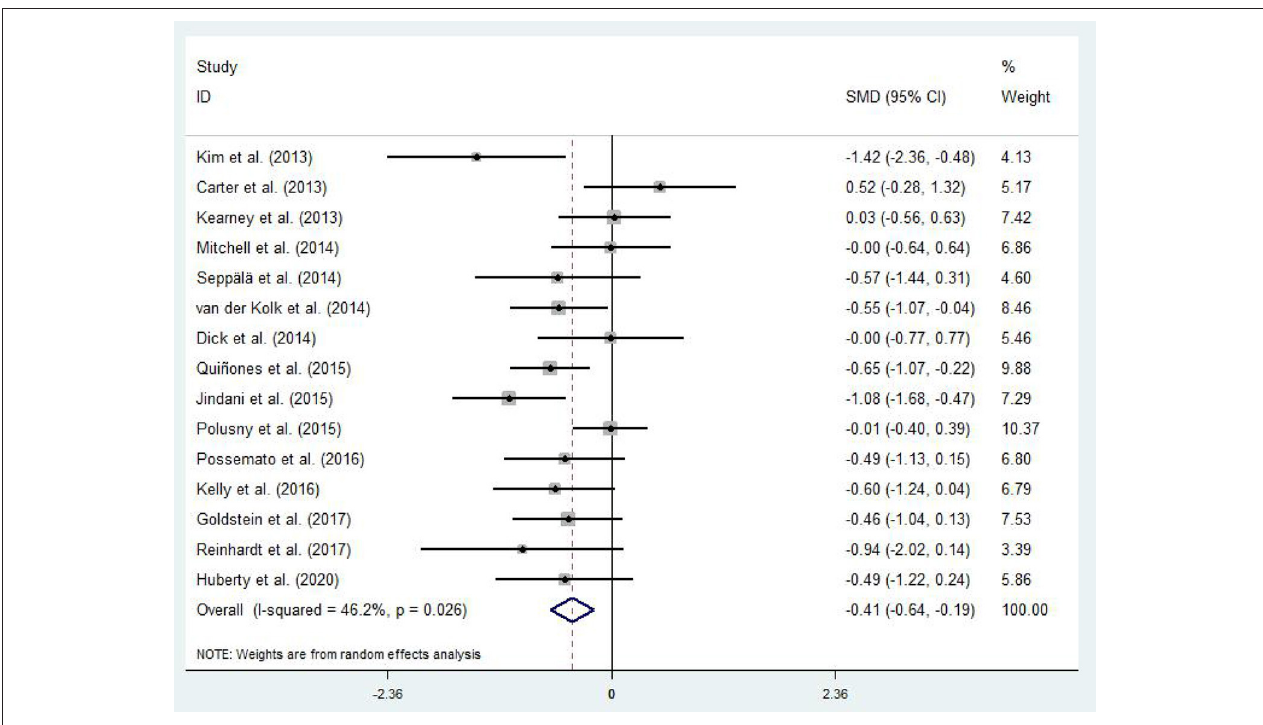
FIGURE 3 | Effect of mind–body exercises on